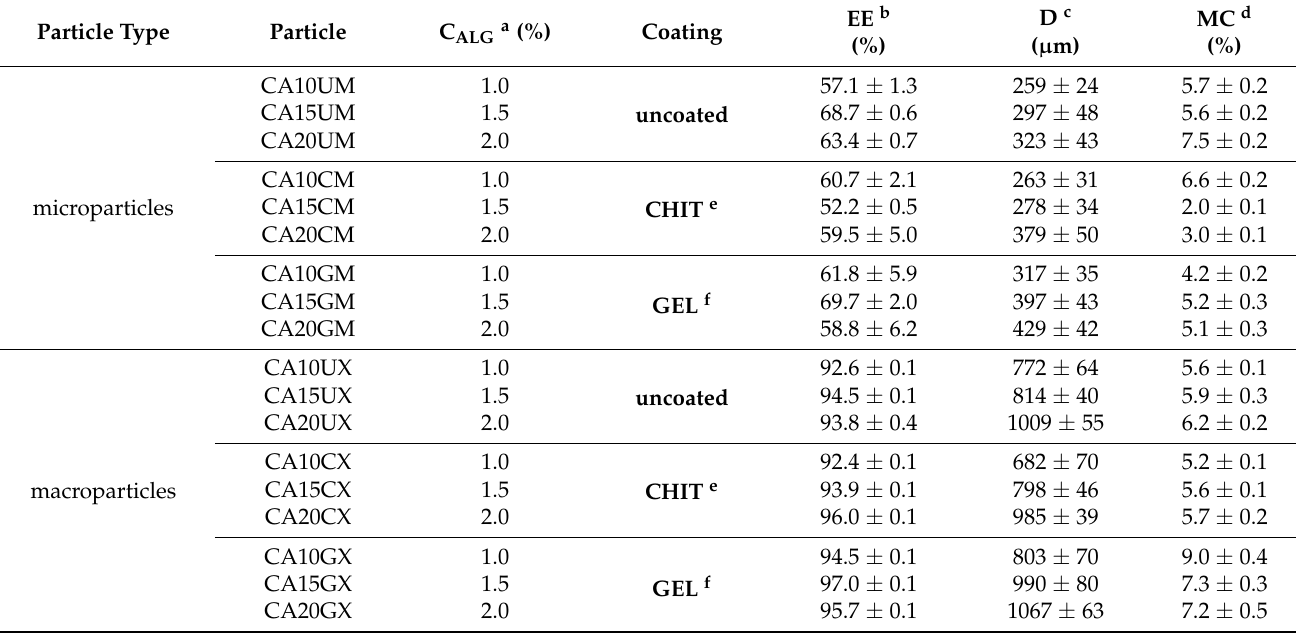
Table 1. Composition and characteristics of the CUR-loaded particles. The results are presented as the means ± S.D.